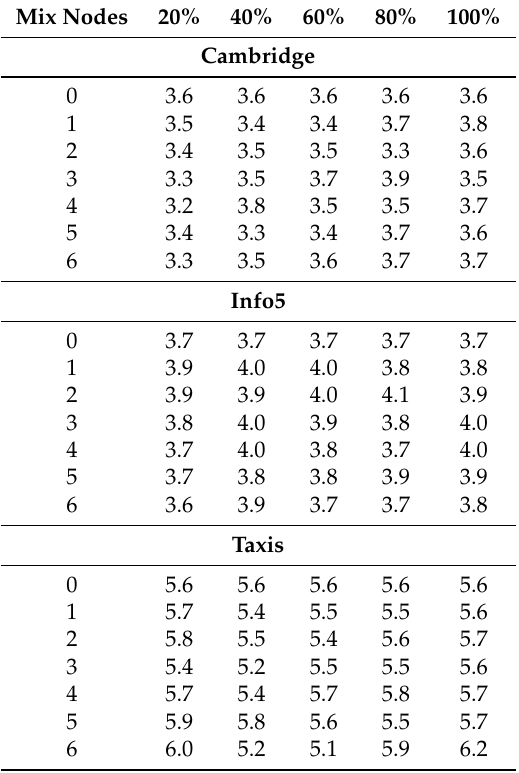
Table 4. Average routing-step path length with random mix